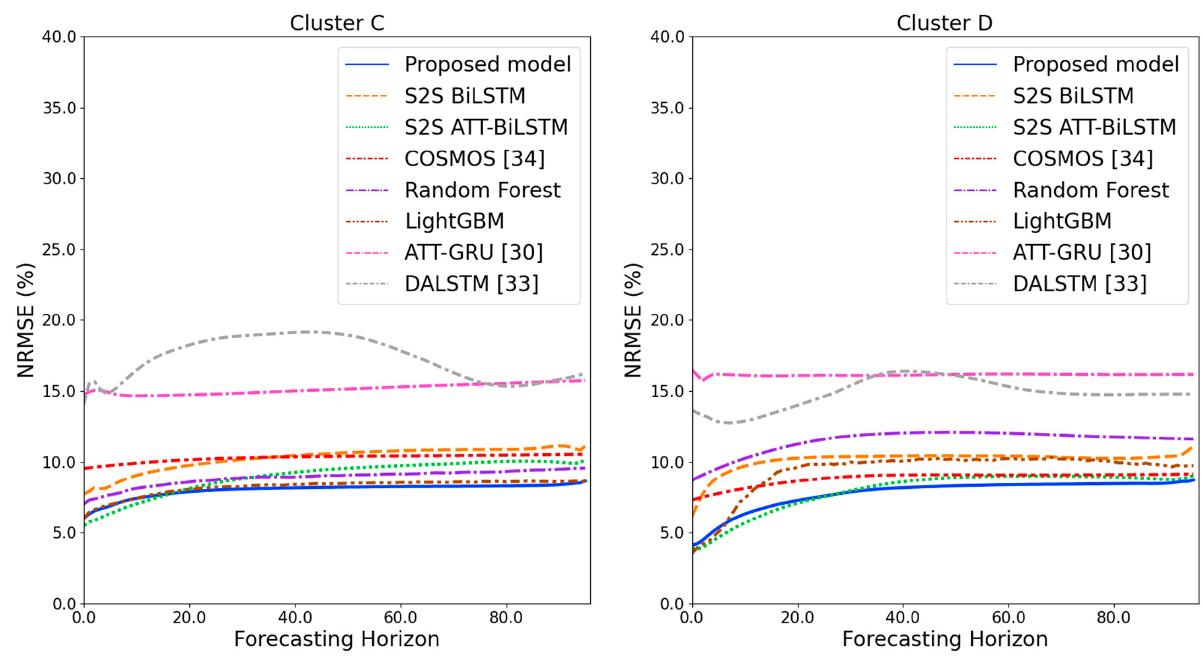
Figure 13. NRMSE results of clusters A and B over the entire forecasting horizon (%).